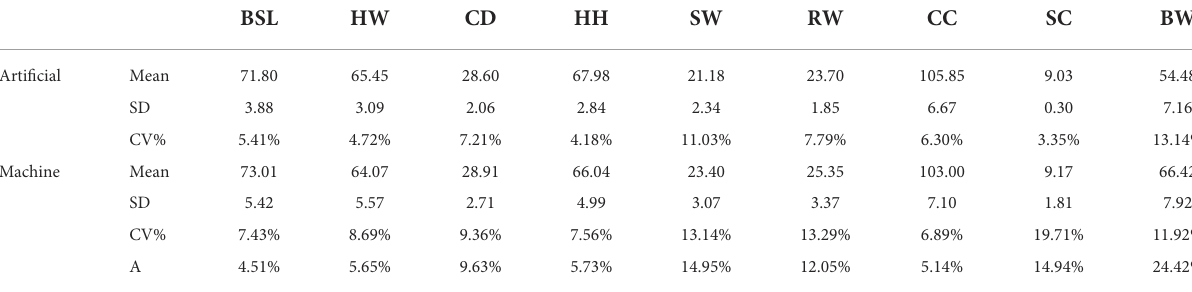
TABLE 2 Percentage error table for manual and machine comparison.